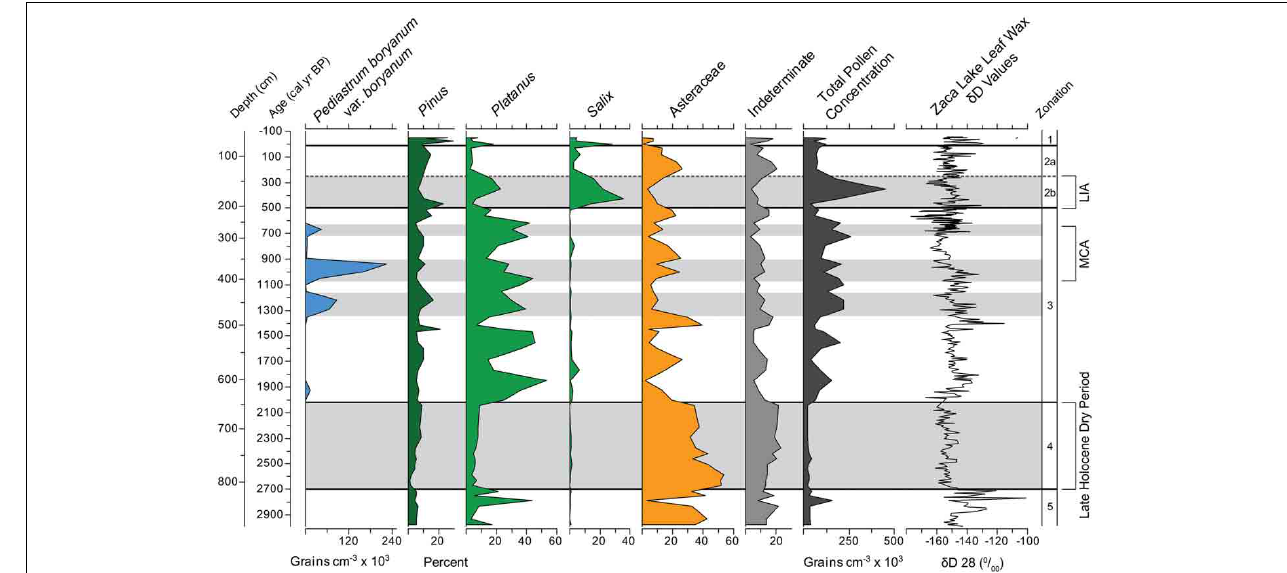
FIGURE 8 | Zaca Lake multi-proxy summary diagram. Leaf wax δ D from Feakins et al. (2014). Gray shading represents periods with identified climate signals discussed in the text. 2700–2000 cal yr BP Late Holocene Dry Period